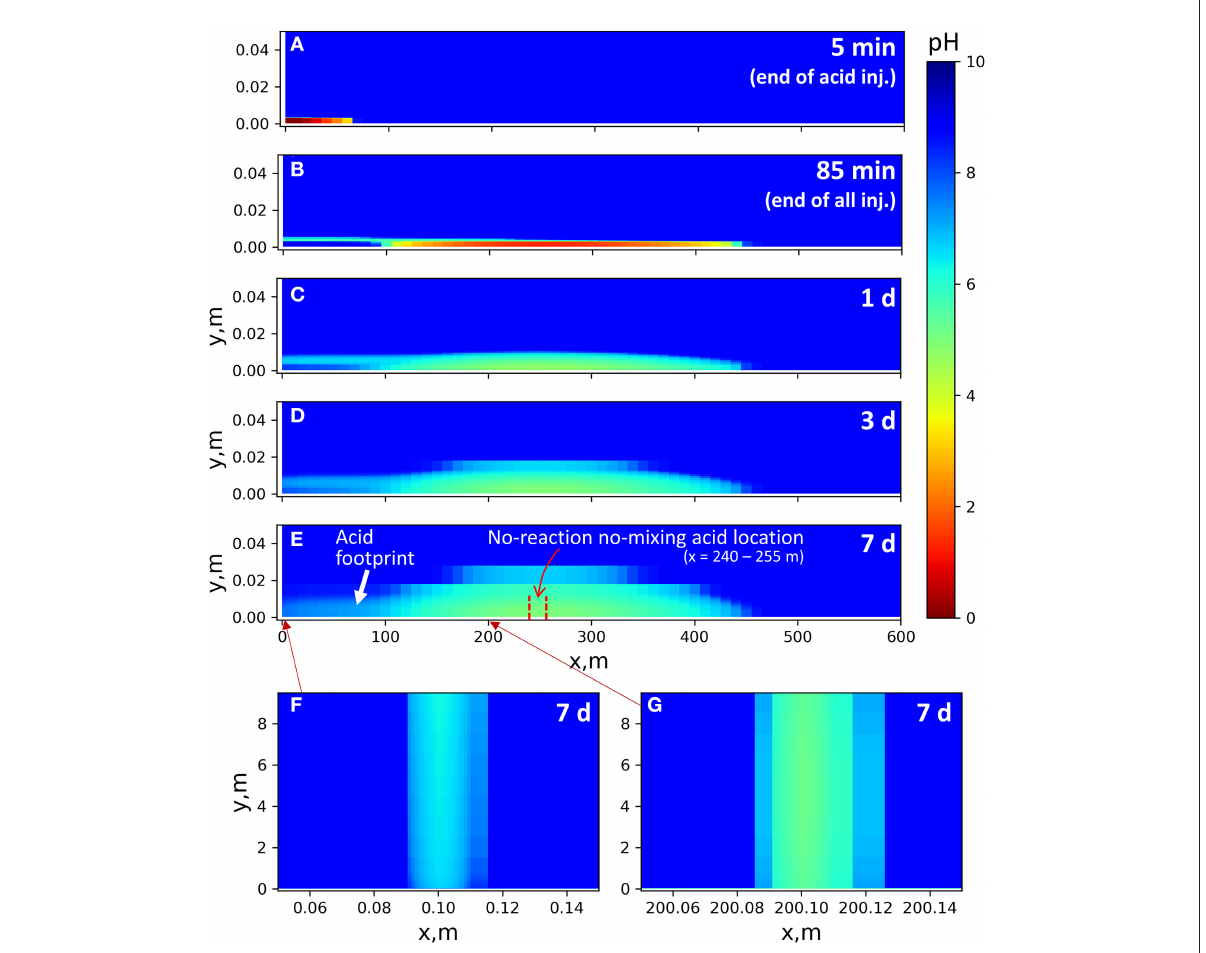
FIGURE5 pH gradient in the 2D sequential model at the end of selected overall reaction times (injection time included). There is no flow in the shale matrix domains. pH gradients in the shale matrix are due to ion diffusion. (A–E) Time-resolved results close to the main fracture (y direction shown up to 5cm). Injection point: (0, 0). Fracture width: 3mm. Flow rate: 0.05 m/s for time = 0–85min, no flow afterward. (F,G) pH results after 7 days of reaction in vertical fractures close to and far from the injection point, mapped for the entire y domain. Fracture width: 0.5mm. Flow rate: 0.005 m/s for 0–85min, no flow